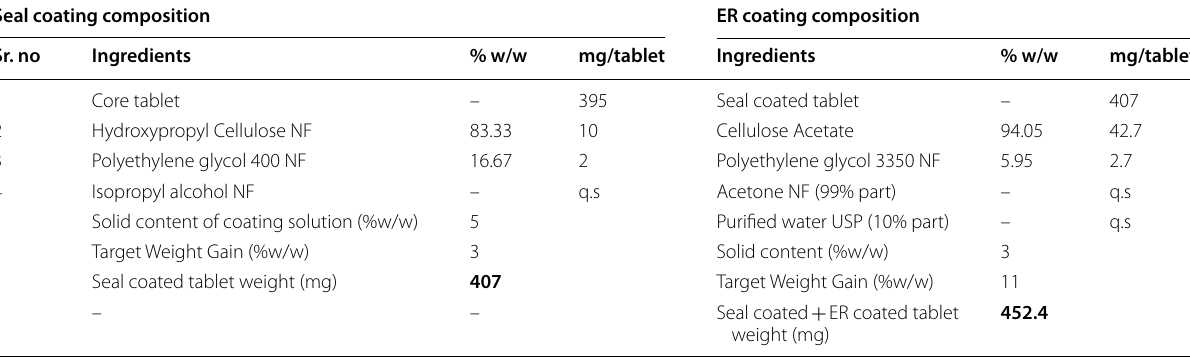
Bold indicates the total weight after seal coating and Extended Release (ER) coating